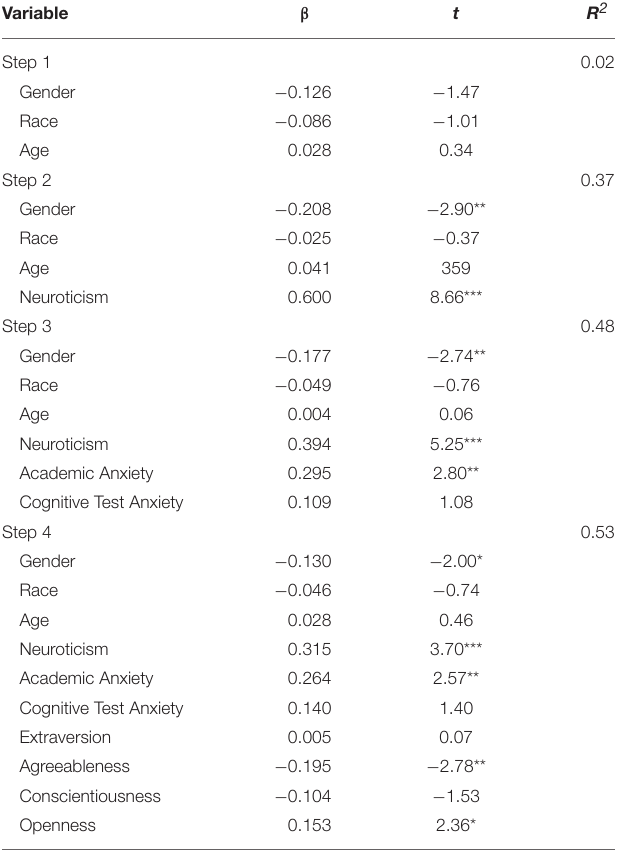
TABLE 2 | Hierarchical linear regression analysis predicting college students’ depressive symptomatology (N = 141) . Variable